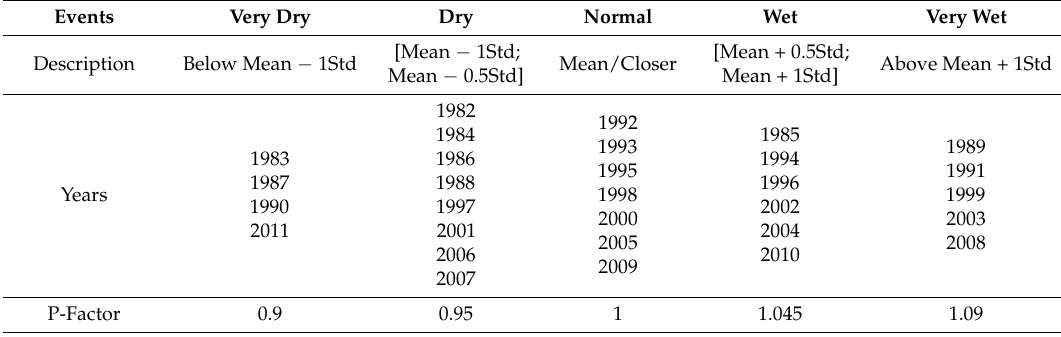
Figure 4. Annual Rainfall Stream flow variability. Table 2. Rainfall characterization.